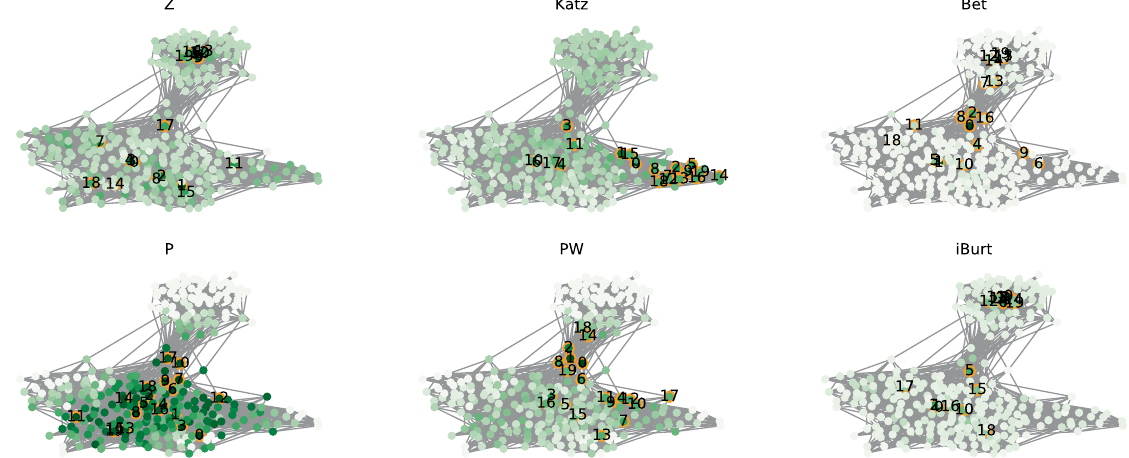
Figure 5. Index values of nodes in the Tohoku network. Each network has 217 nodes colored by their index values, 2696 edges, and five communities. Top 20 nodes are marked by orange circles with labels of the node ranking in each network. The upper community had fewer inter-community links compared to the other four communities below. The values of the top 20 nodes can be found in Supplementary Table S4.